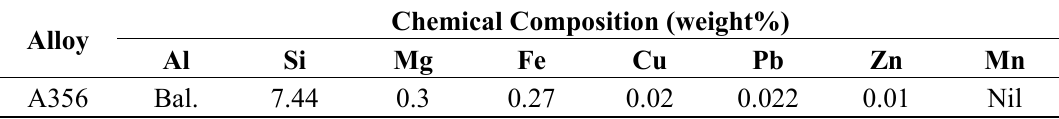
Figure 1. Furnace used for preparing the castings. Table 2. Chemical Composition (in weight%) of A356 cast